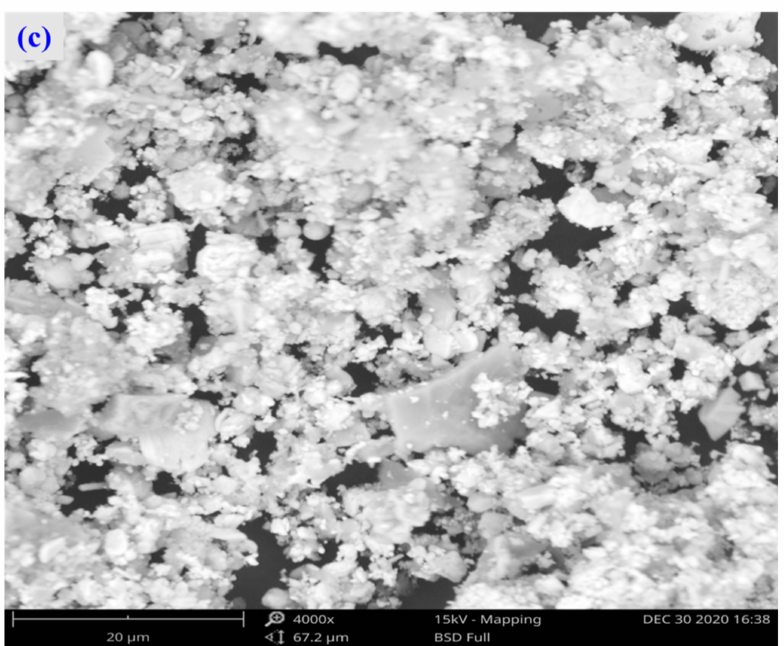
Figure 15. SEM patterns of raw materials ( a ), conventional leaching residue ( b ), and the ultrasonic leaching residue ( c ).